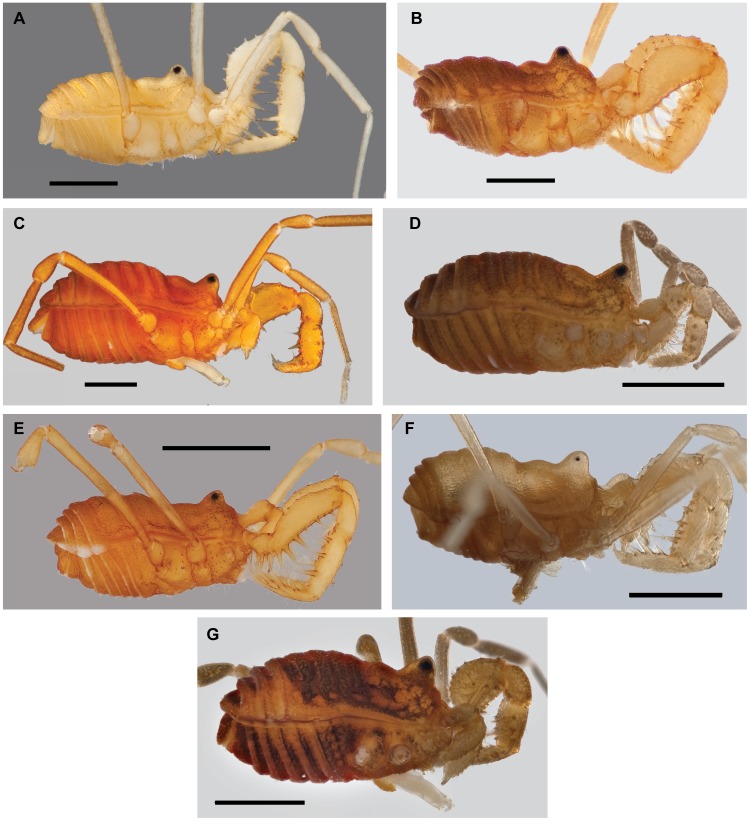
Habitus morphology of the robustus group.A) S. speoventus, paratype male (Cave of the Winds, CO) [835868]. B) S. steinmanni, holotype male (Mallory Cave, CO) [835871]. C) S. robustus male (Apex Valley, CO) [835865]. D) S. glorietus, male (Glorieta Canyon, NM) [835850]. E) S. klomax, holotype female (Taos Ski Valley, NM) [835857]. F) S. jemez, holotype male (Terrero Cave, NM) [835856]. G) S. skywalkeri, paratype male, image horizontally reflected (Manzano Mountains, NM) [835867]. Scale bars = 1 mm. Morphbank numbers indicated in brackets.